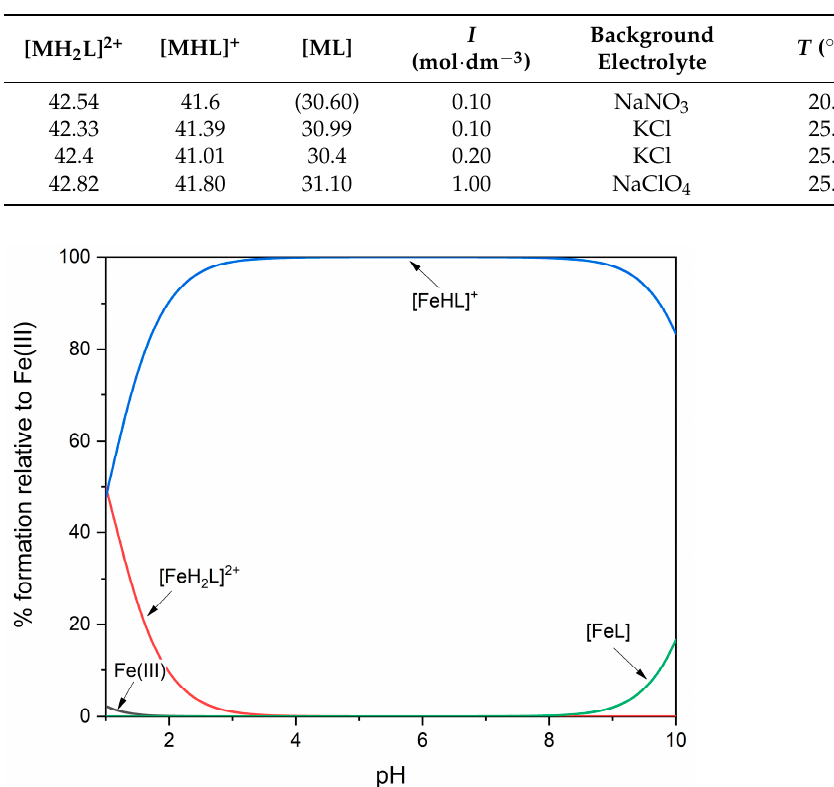
Figure 2. Representative distribution diagram for Fe(III)/DFOB complex-formation equilibria at 25 °C and I = 1.0 mol·dm − 3 (NaClO 4 ) [13].